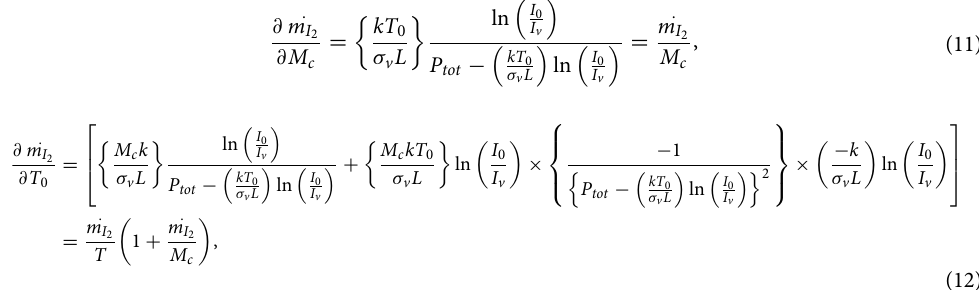
where I 0 and I v are light intensity in form of iodine detector signal without- upper lines and with iodine- bot- tom line (Fig. 5), σ The sensitivity calculations using partial differentiation as given in “Eq. (4)” are: